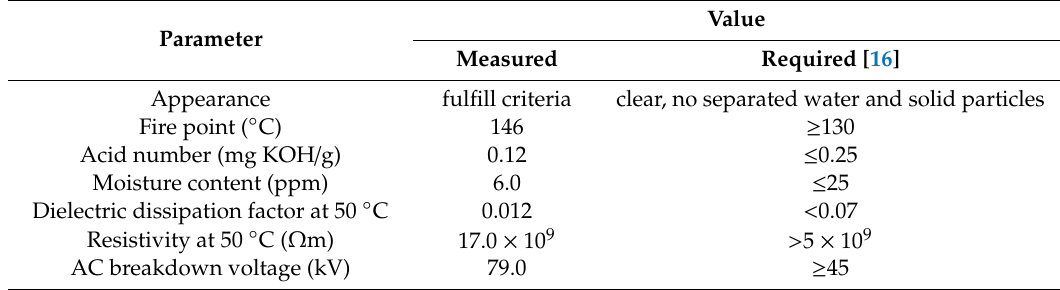
Table 8. Results of the measurements of oil sample taken from a 10 MVA, 110 / 6 kV power transformer.